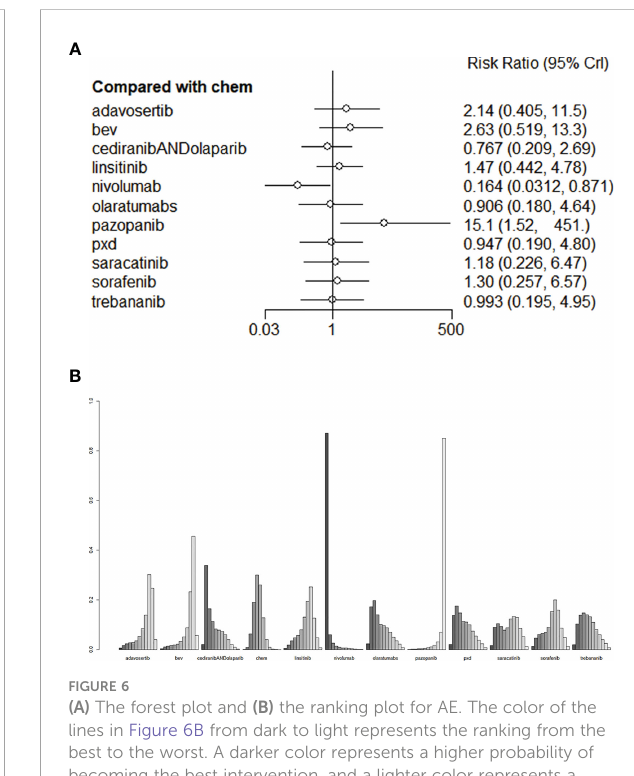
FIGURE 6 (A) The forest plot and (B) the ranking plot for AE. The color of the lines in Figure 6B from dark to light represents the ranking from the best to the worst. A darker color represents a higher probability of becoming the best intervention, and a lighter color represents a lower probability. The cediranibANDcediranib stands for combination medication.